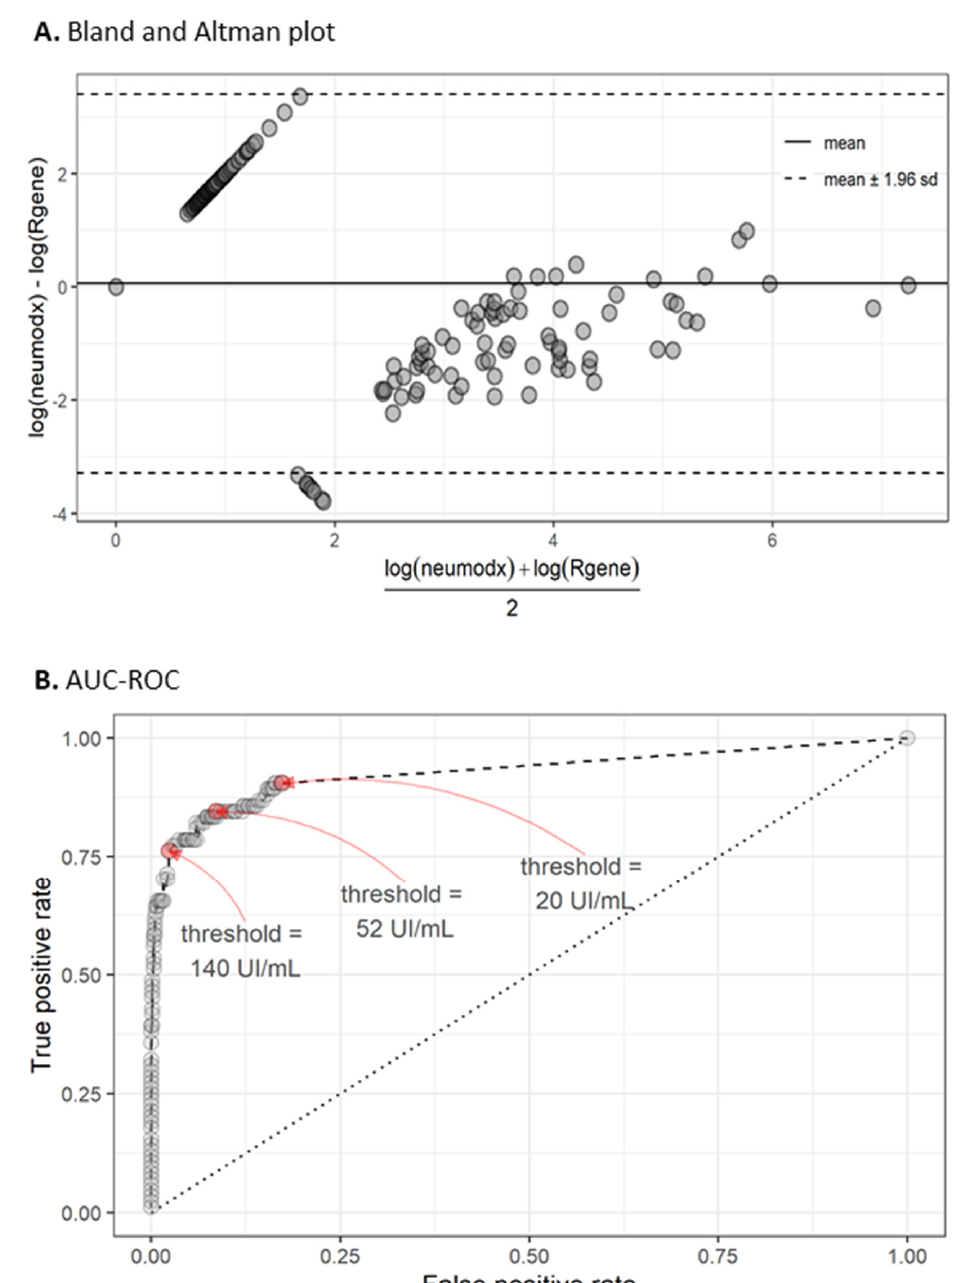
Figure 1. Comparison of the two methods of measuring CMV viral load. ( A ) A Bland–Altman plot (log10 values in IU/mL) showing that all non-zero measurements are coordinated. This graph also highlights the large number of null R-GENE ® and non-null NeuMoDx™ measurements (diagonal dots at top left) due to the 50-fold lower quantification threshold of NeuMoDx™ compared to R- GENE ® . ( B ) AUC-ROC (air under curve-receiver operating characteristic) showing the performance (sensitivity and specificity) of the NeuMoDx™ using R-GENE ® as the reference method. A 140 UI/mL threshold corresponds to the optimization of the geometric mean of the sensitivity and the positive predictive rate (Fowlkes–Mallows index). A 52 UI/mL threshold corresponds to the optimization of the geometric mean of the specificity and sensitivity (G-mean). A 20 UI/mL is the commercial threshold.